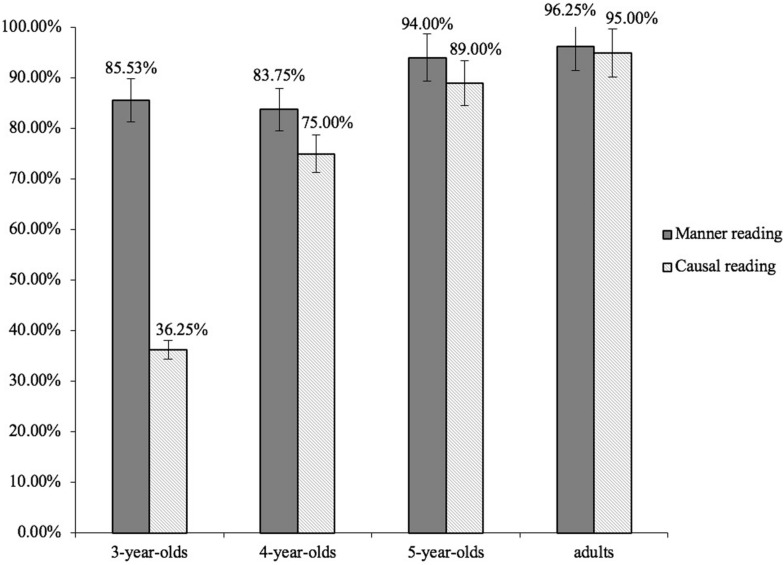
Mean proportions of the two readings in response to the two structures by the four age groups. Solid bars indicate the proportions of manner readings in response to manner questions. Lined bars indicate the proportions of causal readings in response to causal questions. Error bars indicate SEs.